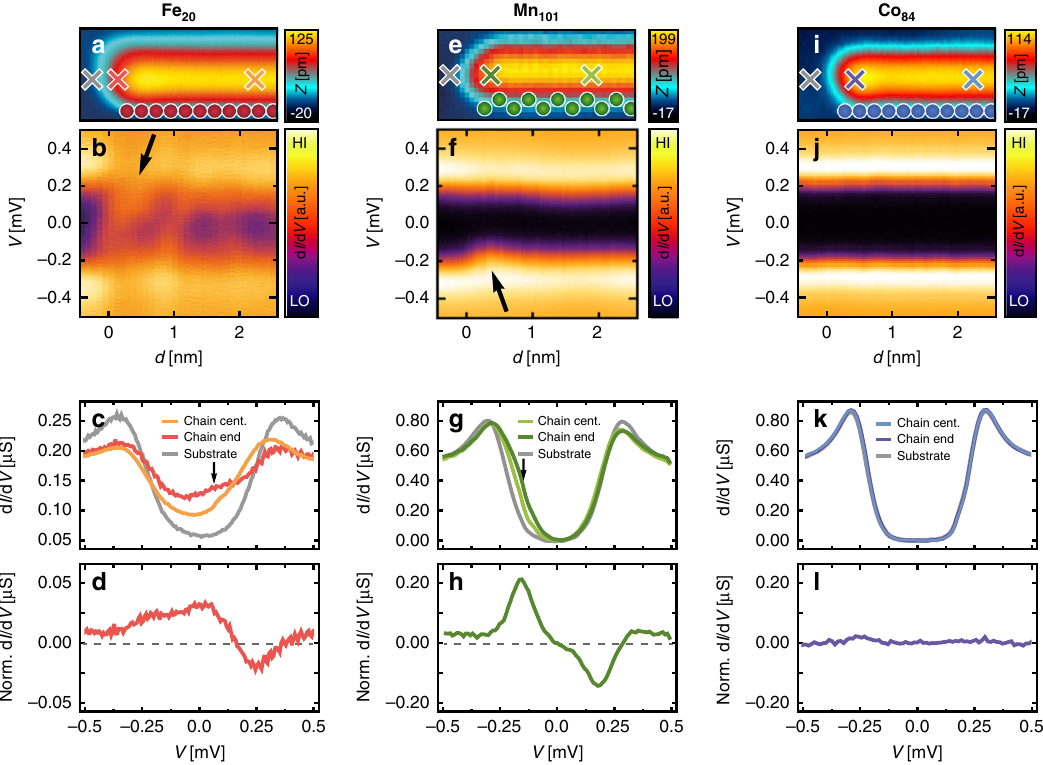
Fig. 2 Low-energy electronic structure at the terminations of the Fe, Mn, and Co chains. a Constant-current scanning tunneling microscope (STM) image of the end of a Fe 20 chain. b Differential tunneling conductance along the Fe 20 chain aligned with the topography shown in ( a ). c d I /d V spectra of the Fe 20 chain and substrate taken at the positions marked by crosses in ( a ) ( V stab = 1 mV, I stab = 0.2 nA, and V mod = 20 µ V). d d I /d V spectrum on the chain ’ s end from ( c ) normalized by subtraction of a spectrum averaged along the chain ’ s interior. e Constant-current STM image of the end of a Mn 101 chain. f Differential tunneling conductance along the Mn 101 chain. g d I /d V spectra of the Mn 101 chain and substrate taken at the positions marked by crosses in ( e ) ( V stab = 1 mV, I stab = 0.5 nA, and V mod = 40 µ V). h d I /d V spectrum on the chain ’ s end from ( g ) normalized by subtraction of a spectrum averaged along the chain ’ s interior. i Constant-current STM image of the end of a Co 84 chain. j Differential tunneling conductance along the Co 84 chain. k d I /d V spectra of the Co 84 chain and substrate taken at the positions marked by crosses in ( i ) ( V stab = 1 mV, I stab = 0.5 nA, and V mod = 40 µ V). l d I /d V spectrum on the chain ’ s end from ( k ) normalized by subtraction of a spectrum averaged along the chain ’ s interior. All data ( a , e , i ) are recorded with V = 6 mV, I = 0.2 nA. Arrows in ( b , c , f , g ): see